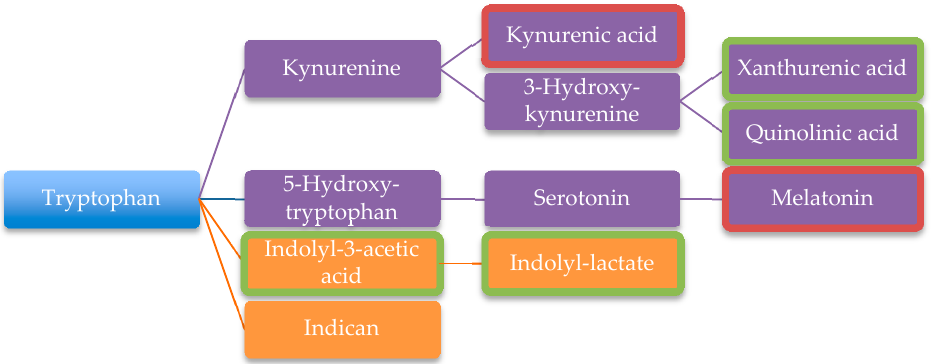
Figure 5. Metabolic pathways of tryptophan. The purple pathways show human metabolism of tryptophan and the orange pathways are observed in bacterial degradation. Green surrounded boxes show elevated metabolites and red surrounded boxes show decreased metabolites in the autistic metabolome [101] .